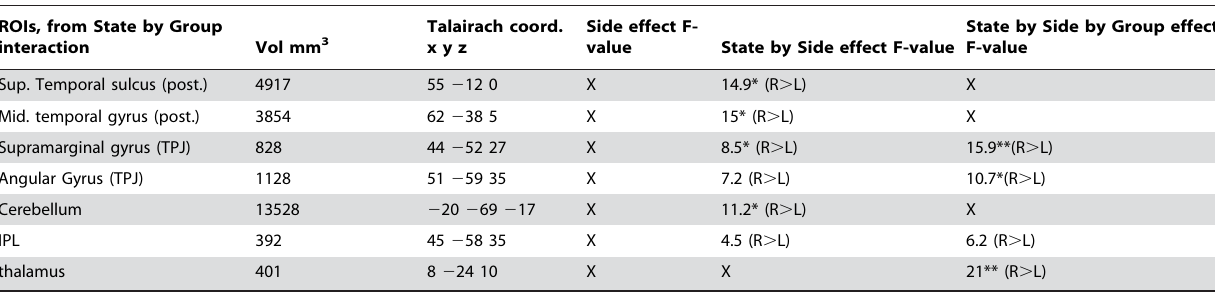
Table 6. Laterality effect.